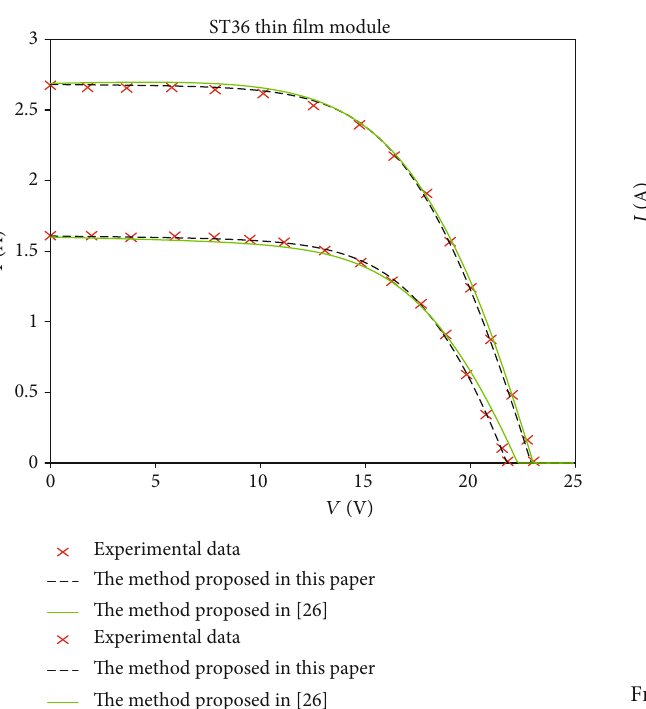
Figure 6: I – V characteristics under varying irradiance for ST36 thin fi lm module ( T = 25 ° C).